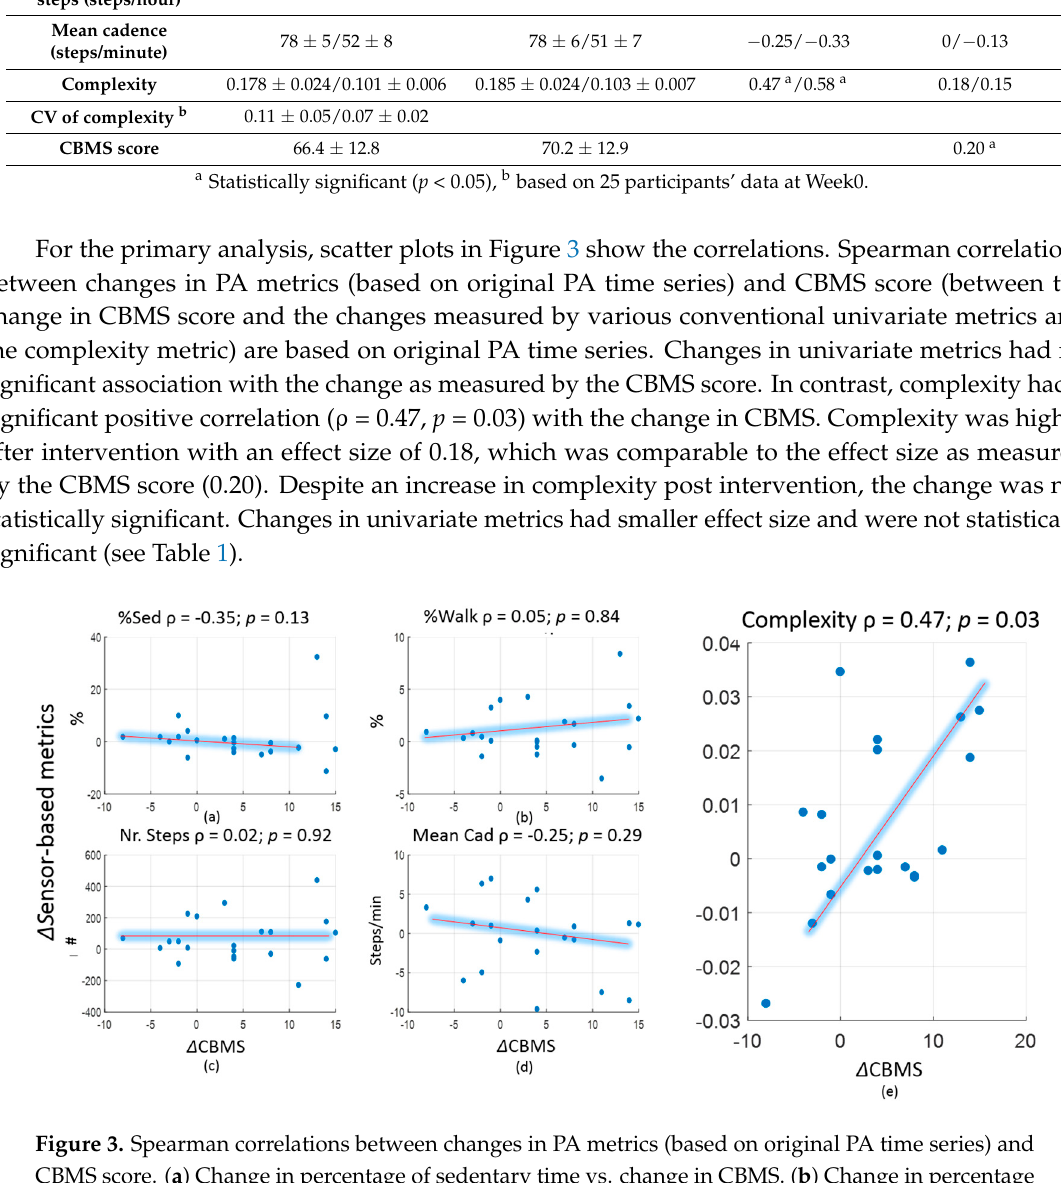
Figure 2. Barcode and mean complexity of one-week PA time series of Week0 ( left ) and Week3 ( right ) in one participant.